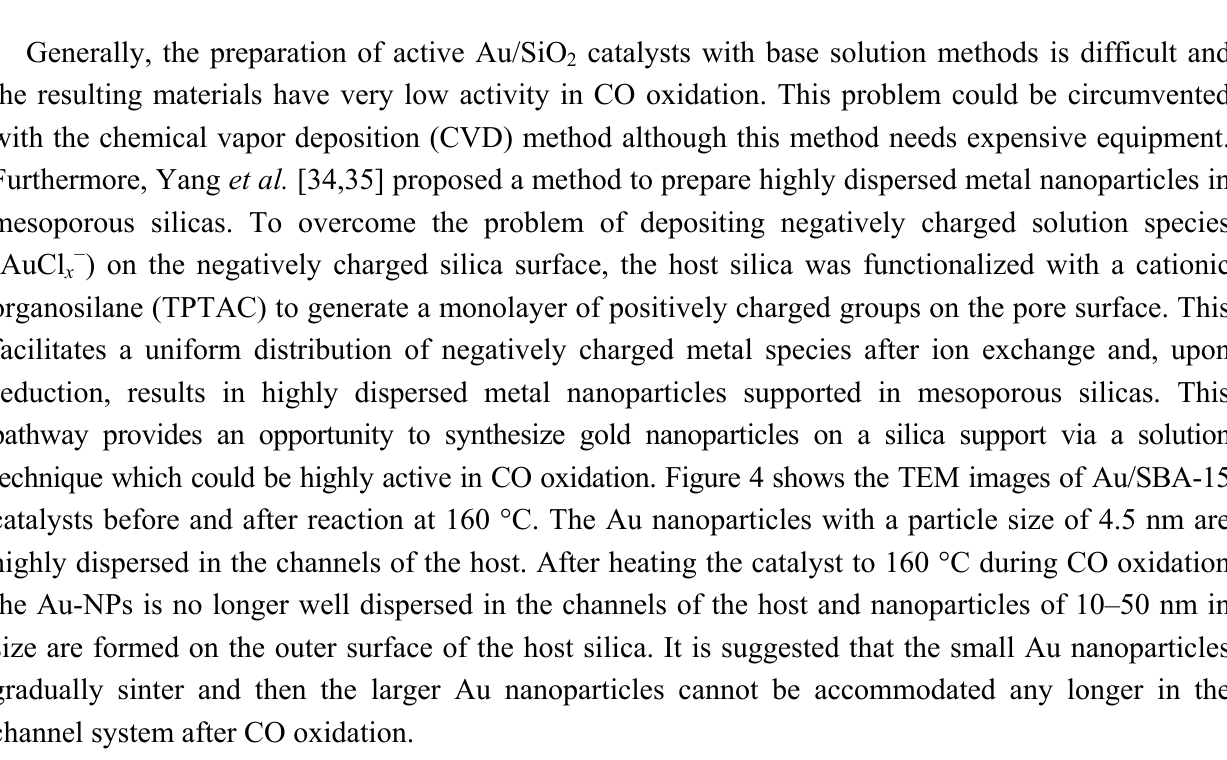
Figure 4. TEM images of Au/SBA-15 ( a ) before and ( b ) after usage in CO oxidation reaction at 160 °C. Reproduced with permission from [35]. Copyright 2002 WILEY-VCH Verlag GmbH & Co. KGaA,